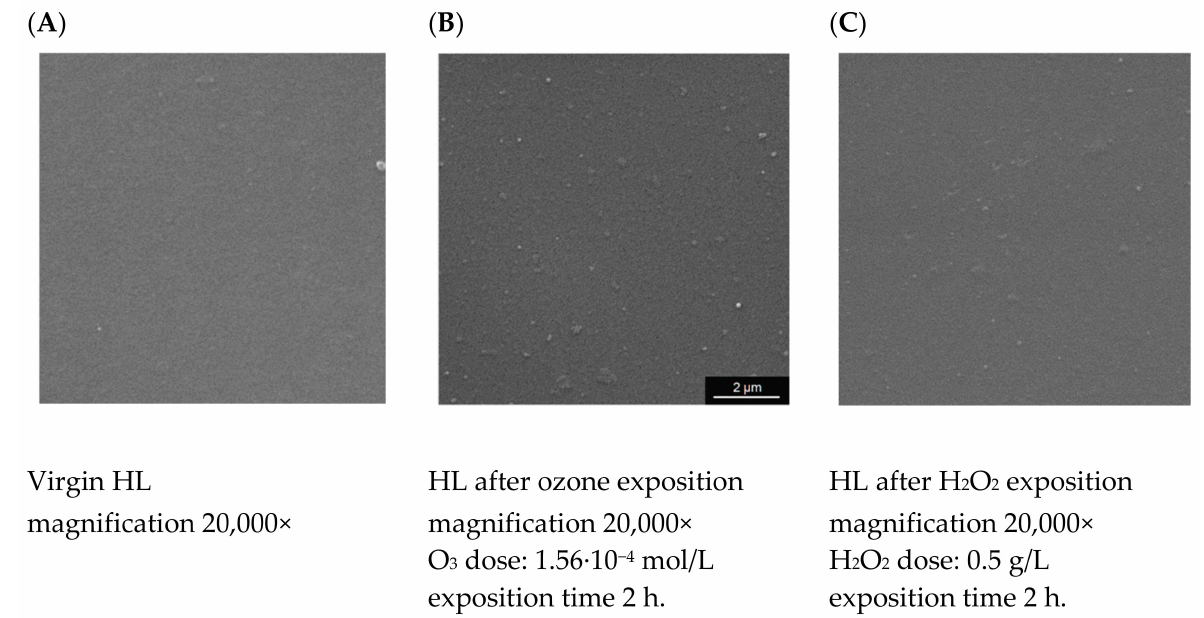
Figure 5. SEM pictures of the HL membrane: ( A ) virgin HL; ( B ) HL after ozone exposure; ( C ) HL after H 2 O 2